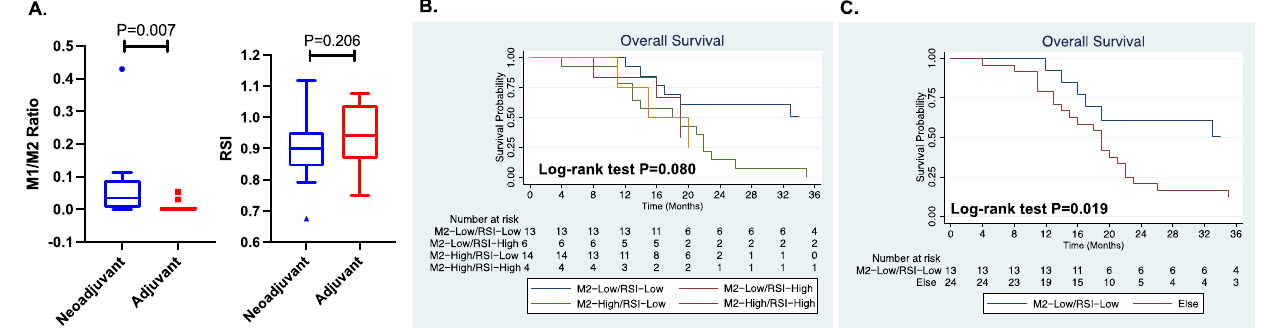
Figure 4. ( A ) From an immunotherapy trial dataset (GSE121810), the ratio of M1/M2 macrophage and the mean value of RSI in neoadjuvant and adjuvant arm are compared. p -value was estimated with analysis of variance. ( B ) From the Glioma Longitudinal Analysis Consortium (GLASS), overall survival for recurrent glioblastoma population is compared, stratified by M2 macrophage and RSI status. p -value was estimated by log-rank test. ( C ) Comparison of overall survival between M2 macrophage-low and RSI-low group versus other population in recurrent glioblastoma. Abbreviations: M1, M1 macrophage; M2, M2 macrophage; RSI, radiosensitive index.